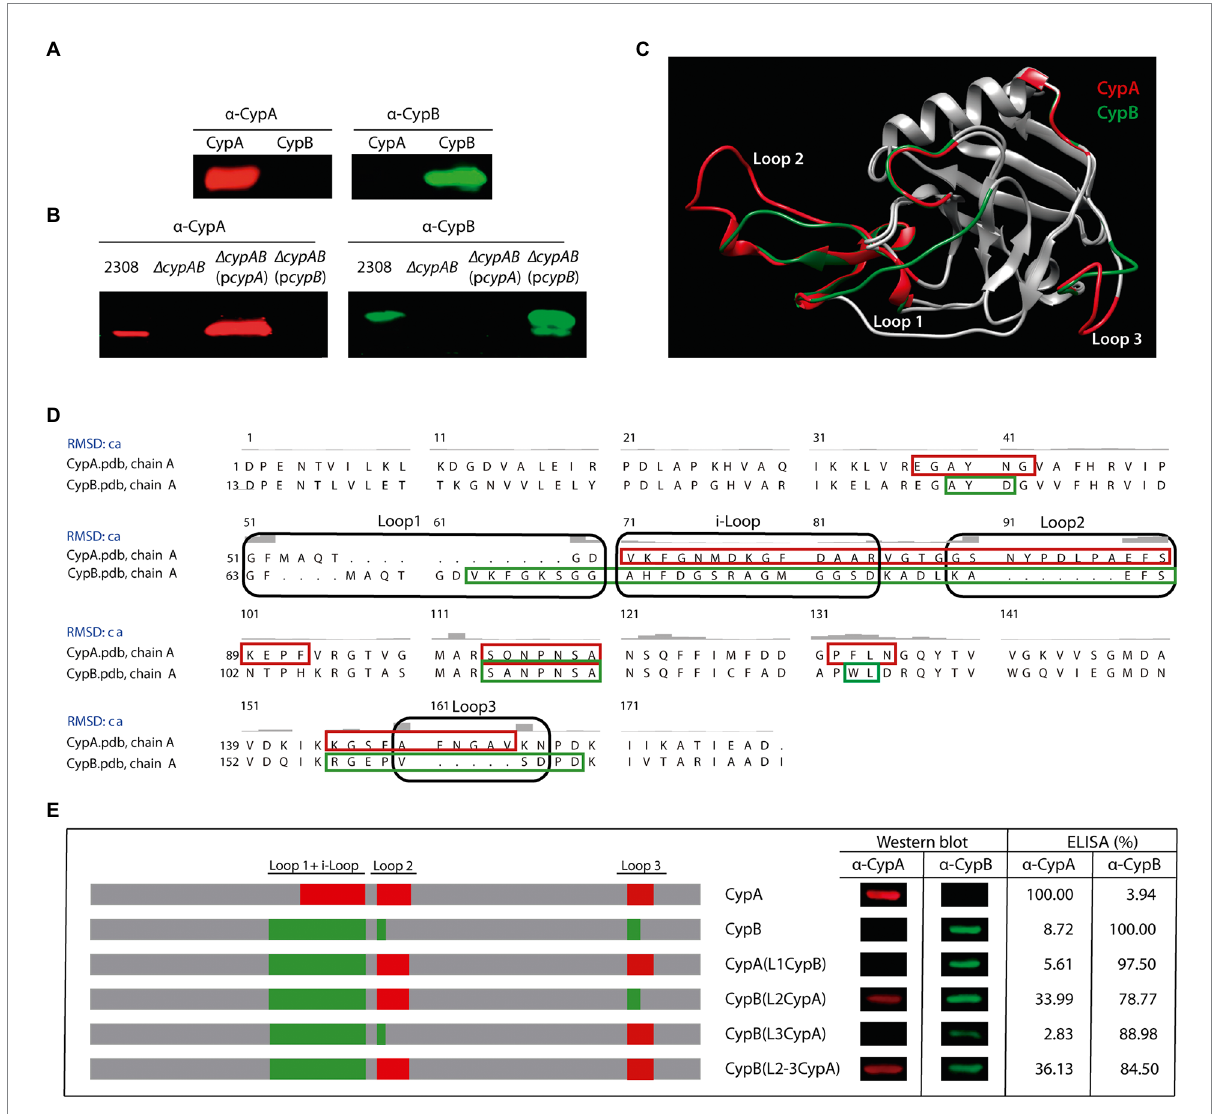
FIGURE 6 Differential immunodominant loops between CypA and CypB. Western blot analysis of (A) CypA and CypB recombinant proteins and (B) different Brucella whole-cell lysates probed with mouse antibodies produced against CypA or CypB. (C) Overlap of the three-dimensional structural model for B. abortus cyclophilins CypA and CypB. Swiss-model and Chimera 1.14 programs were used for modeling and the comparison of the predicted three-dimensional structure, respectively. The BepiPred-2.0 algorithm was used to predict linear epitopes. Immunodominant epitopes of CypA and CypB are marked in red and green, respectively. (D) Sequence alignment of B. abortus cyclophilins. Loops and i-Loop are indicated in a black open box. Linear epitopes are indicated in green open boxes for CypA or red open boxes for CypB. (E) Western blot analysis and indirect ELISA of different recombinant chimeras of CypA and CypB were revealed with anti-CypA or anti-CypB antibodies. The results are representative of three independent